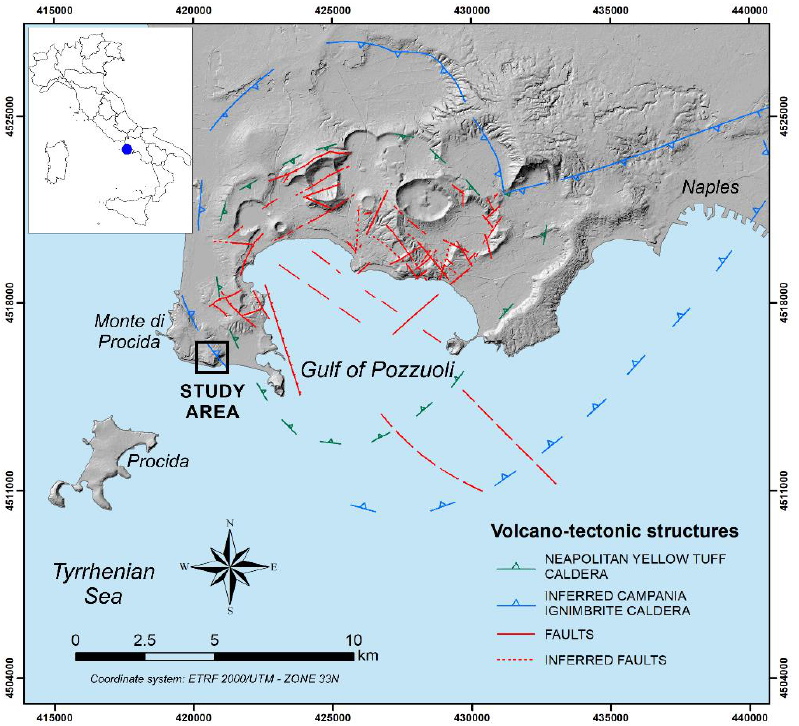
Figure 1. Structural sketch map of the Campi Flegrei volcanic area with location of the study site.